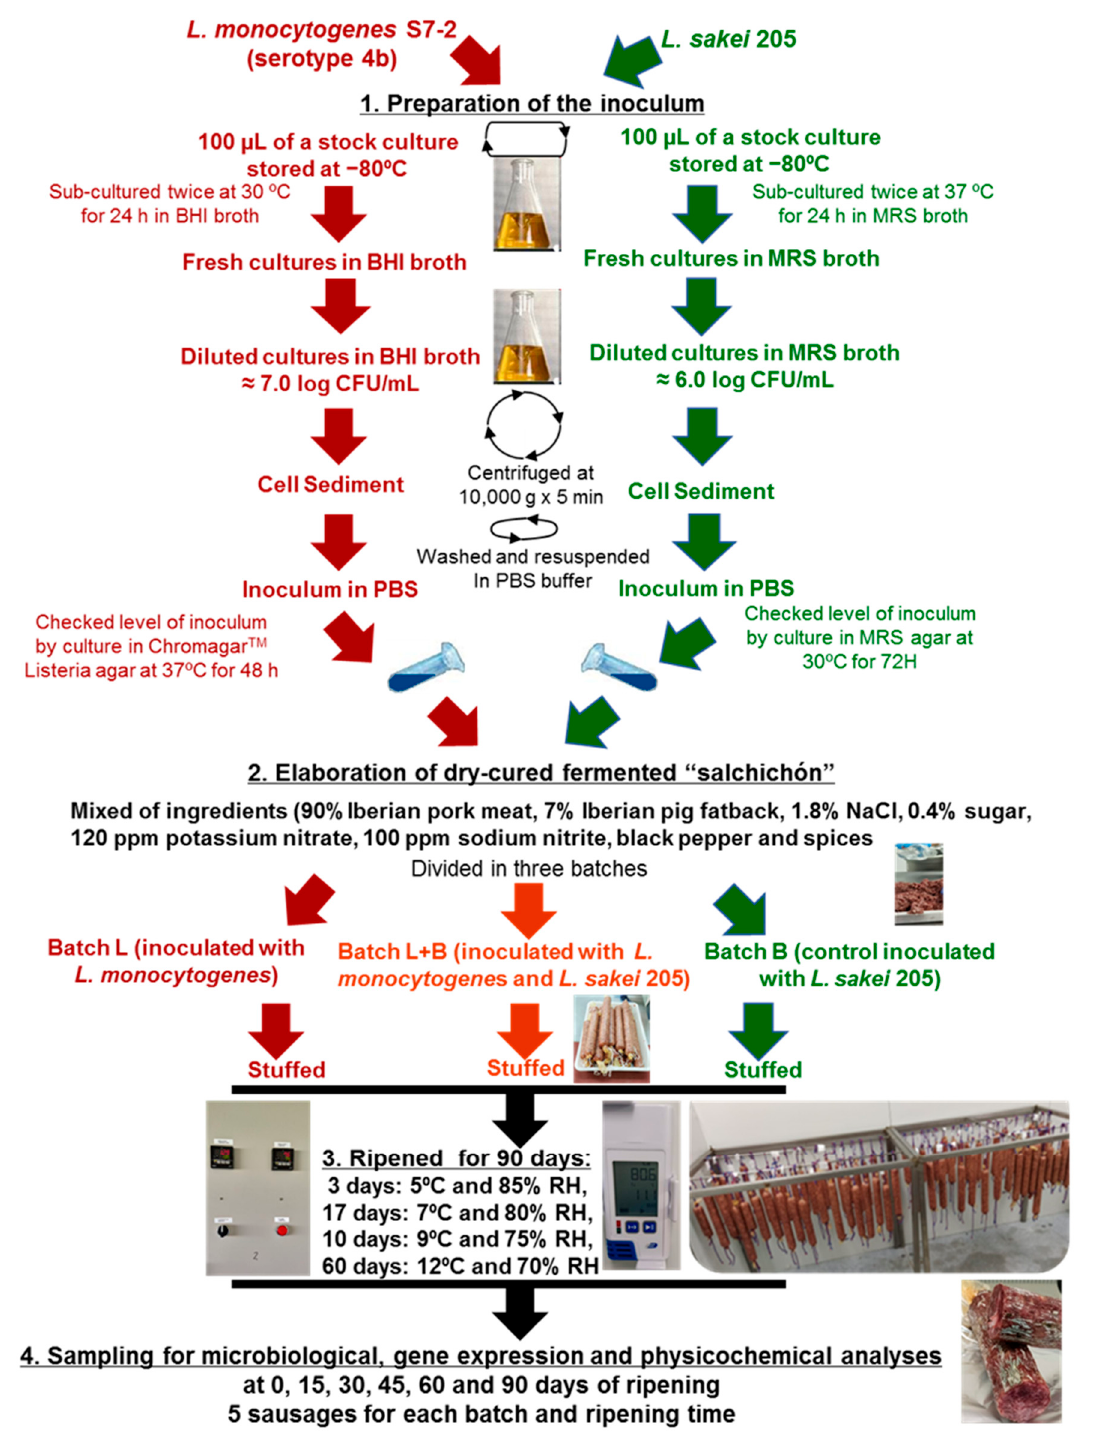
Figure 1. Scheme of the methodology followed in this work for preparing the inoculum, elaboration, and ripening conditions of the inoculated “salchichón” and sampling.